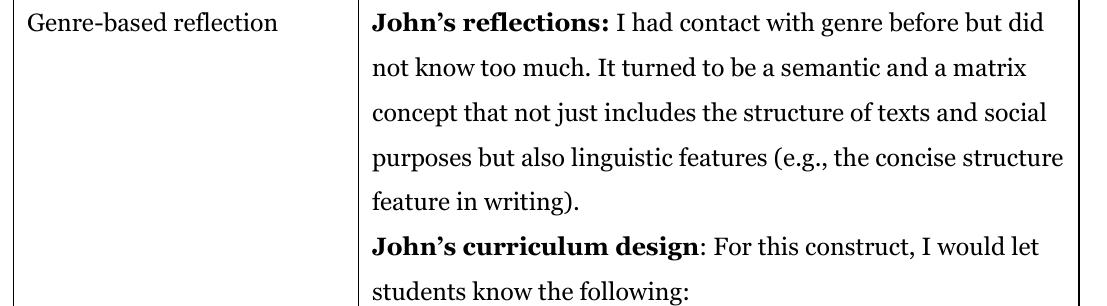
Johns’ Understanding of SFL-Based Constructs and Relevant Curriculum Planning Genre-based reflection John’s reflections: I had contact with genre before but did not know too much. It turned to be a semantic and a